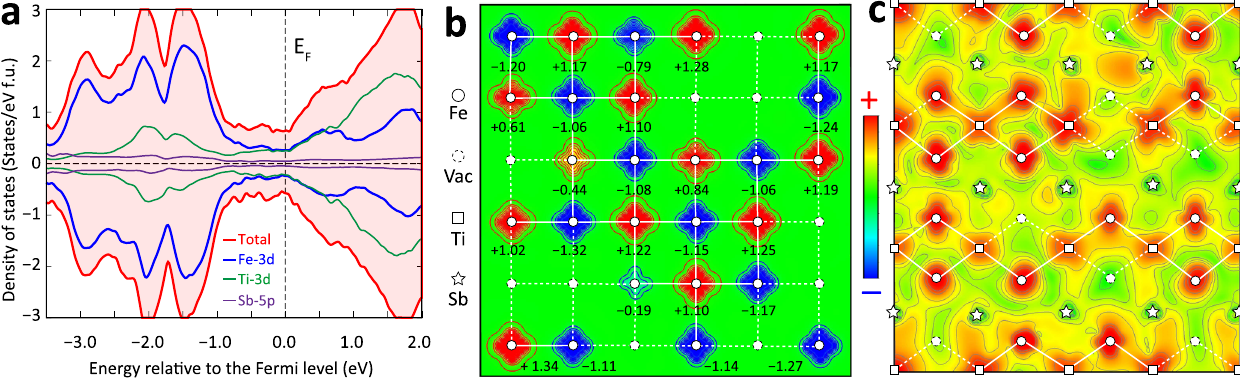
Fig. 5 Bad metallicity, antiferromagnetism, transport networks of itinerant electrons, and spin fl uctuations in TiFe 1.33 Sb from theoretical simulations. a Electronic density of states. b Spin density of a (001) plane containing Fe 4 c and Fe 4 d atoms with the local magnetic moments denoted by the number below the atoms. A redder (bluer) color denotes a more positive (negative) value, and the rule also applies to subplots ( c ). c Electron density in logarithmic scale on a (110) plane from E F − 0.1 to E F + 0.1, where E F is the Fermi level (spin-up channel only, See Supplementary Fig. 17 for spin-down